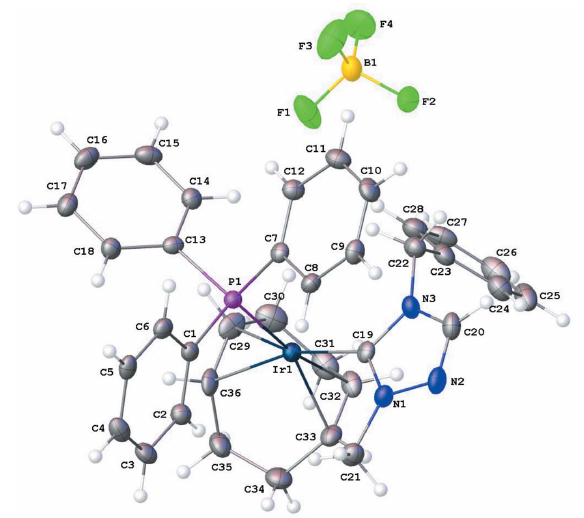
Figure 1 The molecular entities in the crystal structure of the title compound ( 4 ). Displacement ellipsoids are drawn at the 50% probability level.